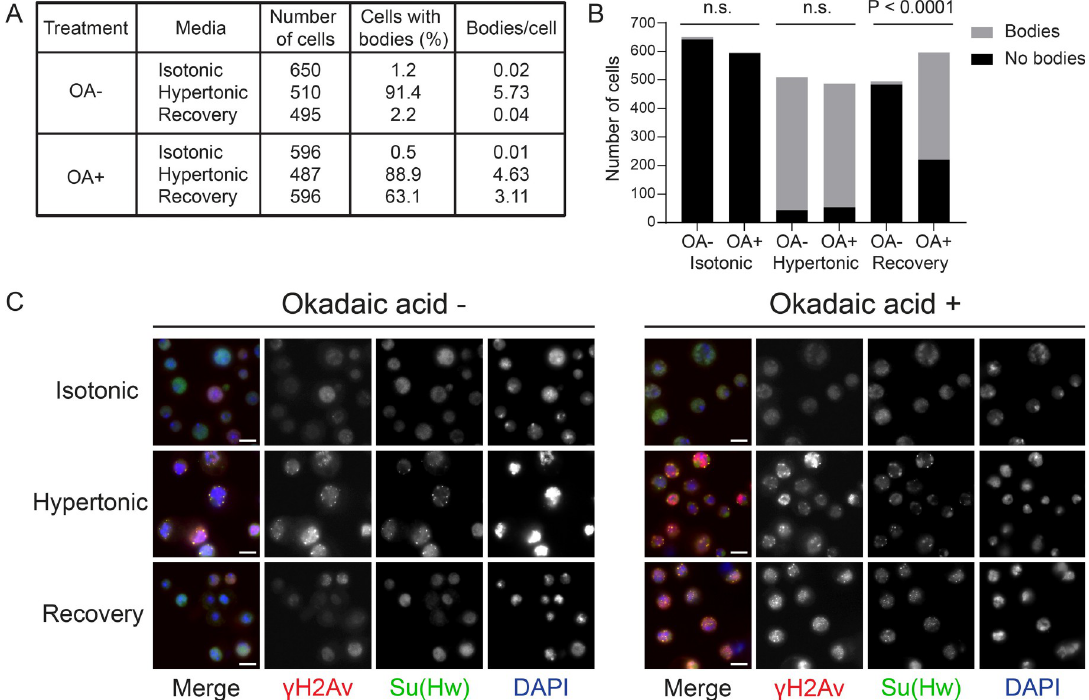
Fig 6. Phosphatase inhibition prevents recovery from insulator body formation after osmotic stress. A. Tabulated results from OA (okadaic acid) treatment in osmotic stress and recovery. B. Bar graph showing the number of cells displaying bodies (grey) and those not displaying bodies (black). OA- and OA+ treatments are shown for each osmotic condition. P-values were determined using Fisher’s exact test. n. s. = not significant. C. Osmotic stress and recovery in the absence of okadaic acid (left) in the presence of okadaic acid (right). Representative images are shown of S2 cells in isotonic media, in hypertonic stress media, and recovering in isotonic media. Merged images are shown on the left, with each channel shown independently in greyscale. Scale bars represent 5 μ m.